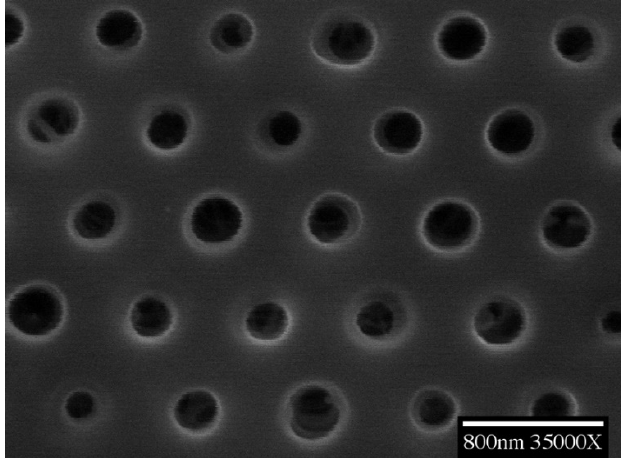
Figure 3. SEM image of the photonic crystal structures fabricated via interference lithography (top view).